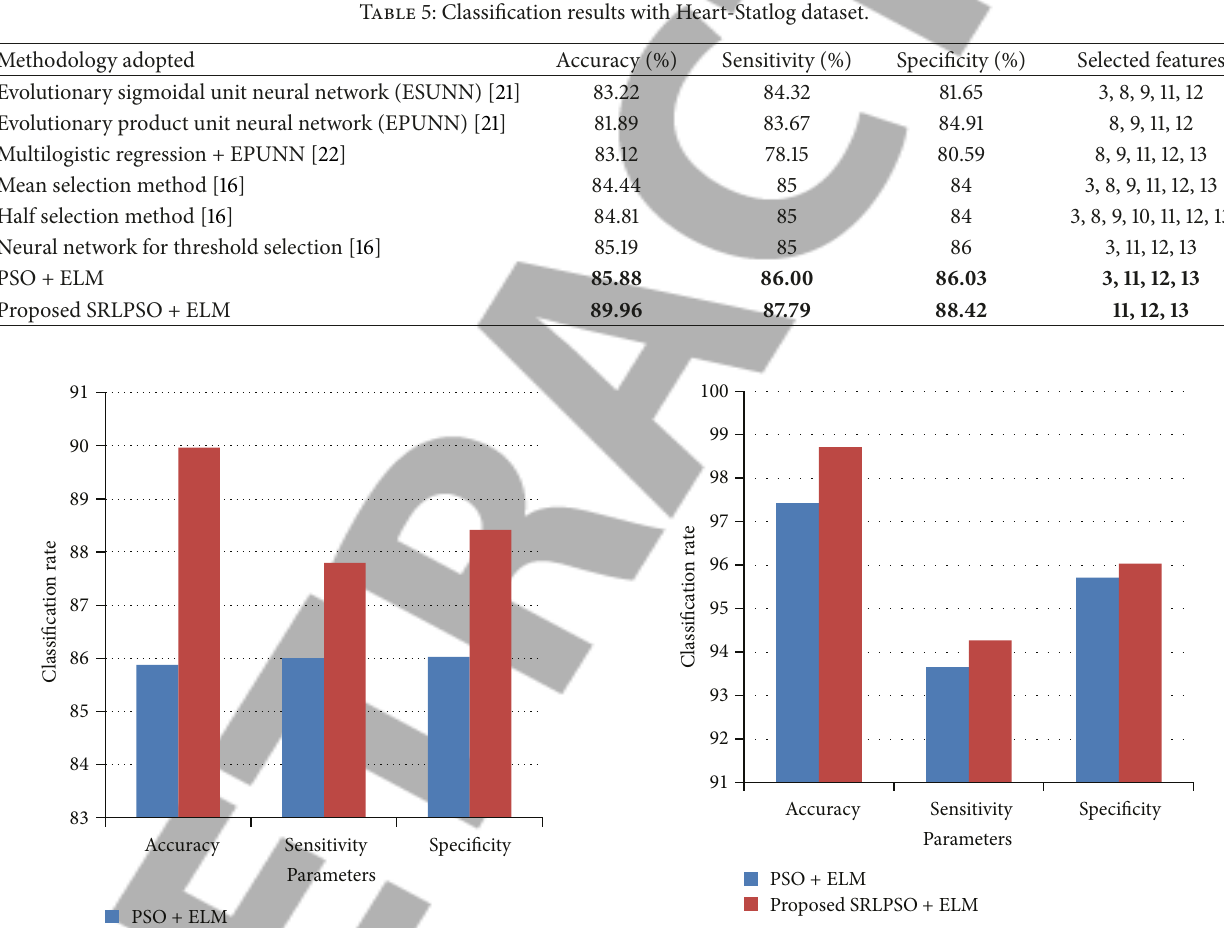
Figure 7: Classification rate for Hepatitis